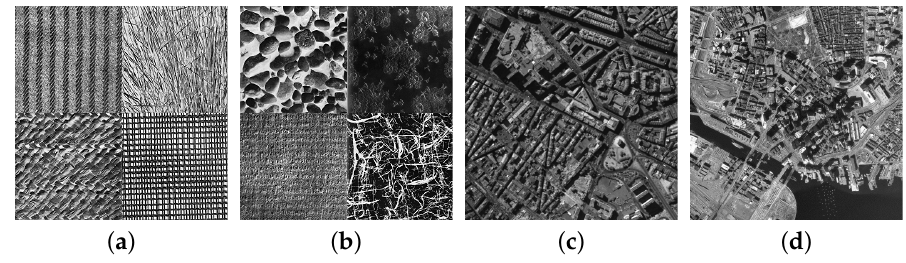
Figure 2. Test images. ( a ) Texture1. ( b ) Texture2. ( c ) Satellite1. ( d )